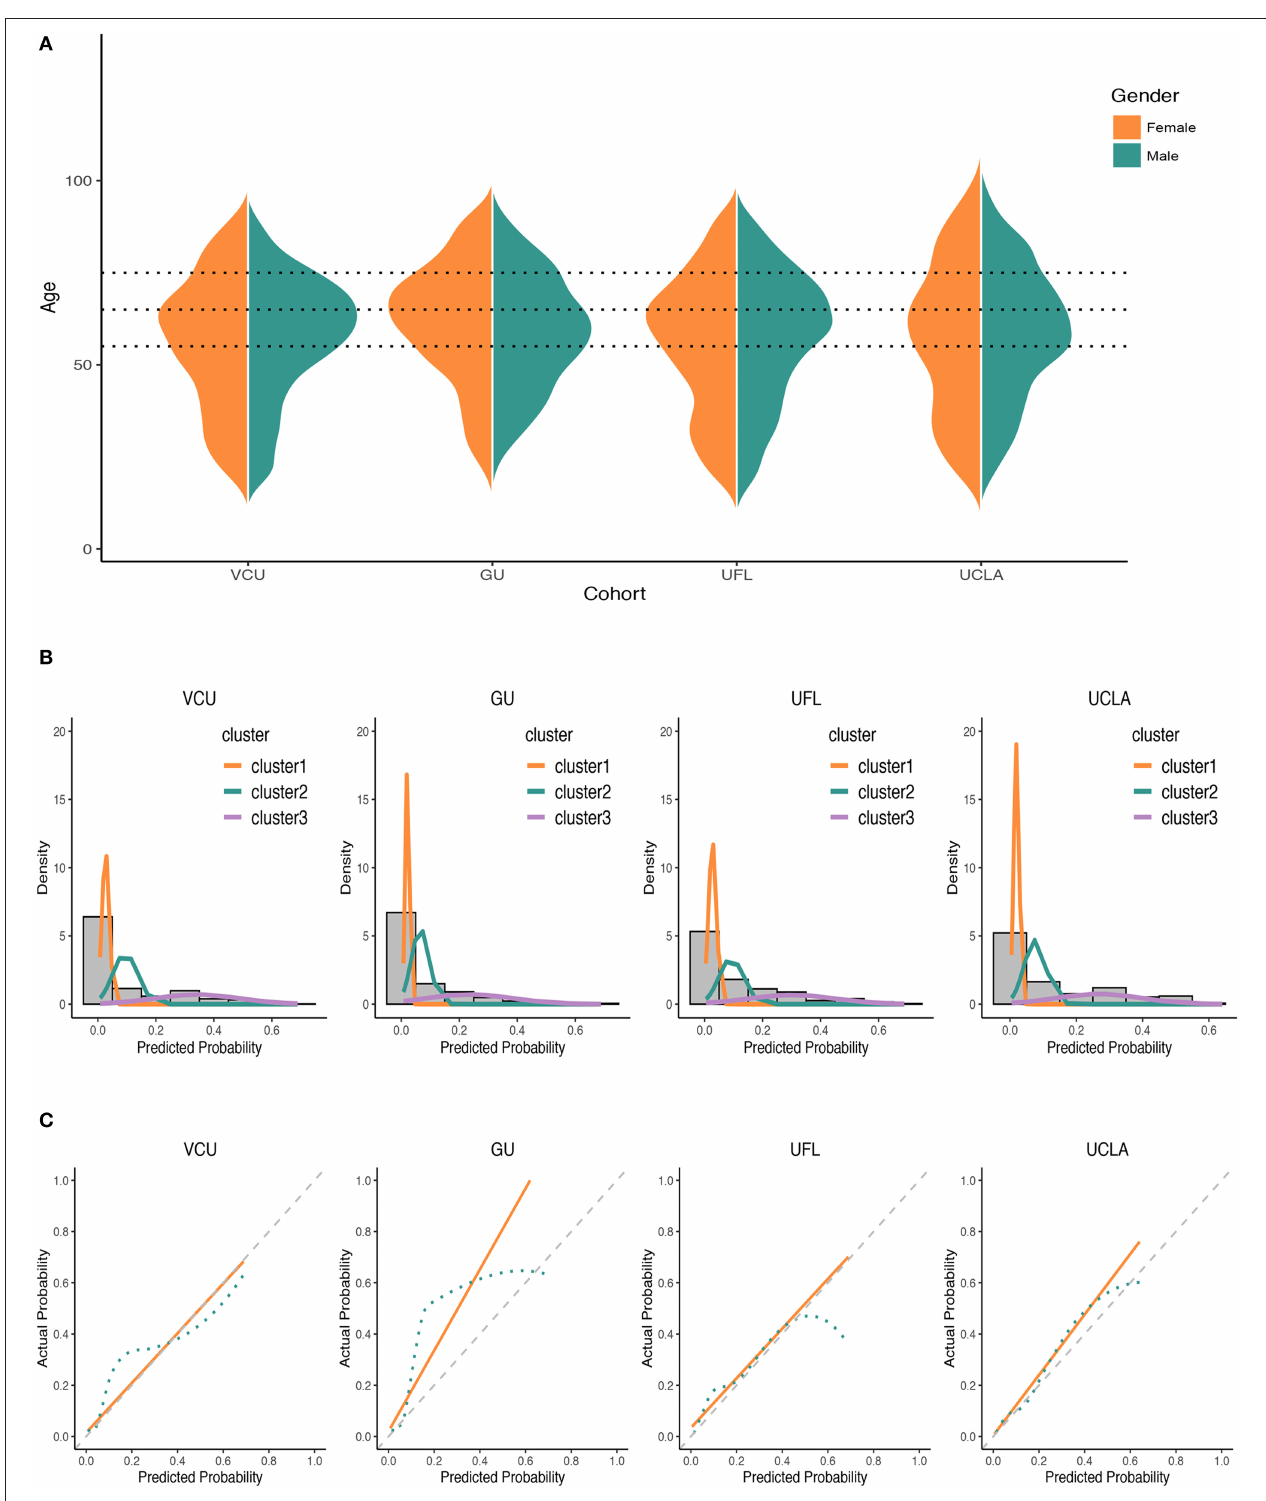
FIGURE 3 | Distribution of demographic variables, discrimination, and calibration ability of the two-step method in the derivation cohort. (A) Distributions of demographic variables. (B) GMM distributions among different cohorts. (C) Calibration curves for two-step method using logistic calibration and locally weighted scatterplot smoothing (lowess). The dot lines in (A) were age cutoffs. The first cluster line plot of VCU in (B) was truncated for convenient comparison with other cohorts. The actual peak of this line was at around 95.